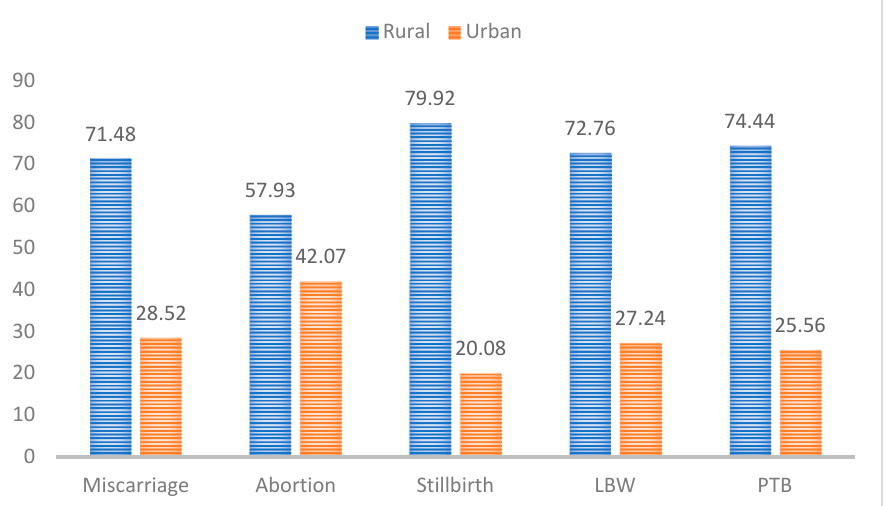
Figure 6. Percentage of women in each adverse birth outcome category by residential area. Source: Authors’ calculations.